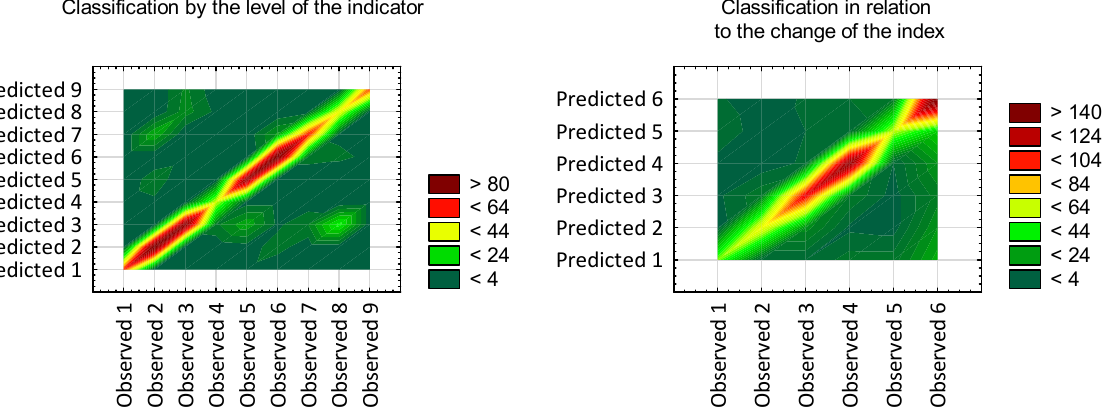
Figure 4. Classification by level of indicator and in relation to the change of the index. Source: own study.